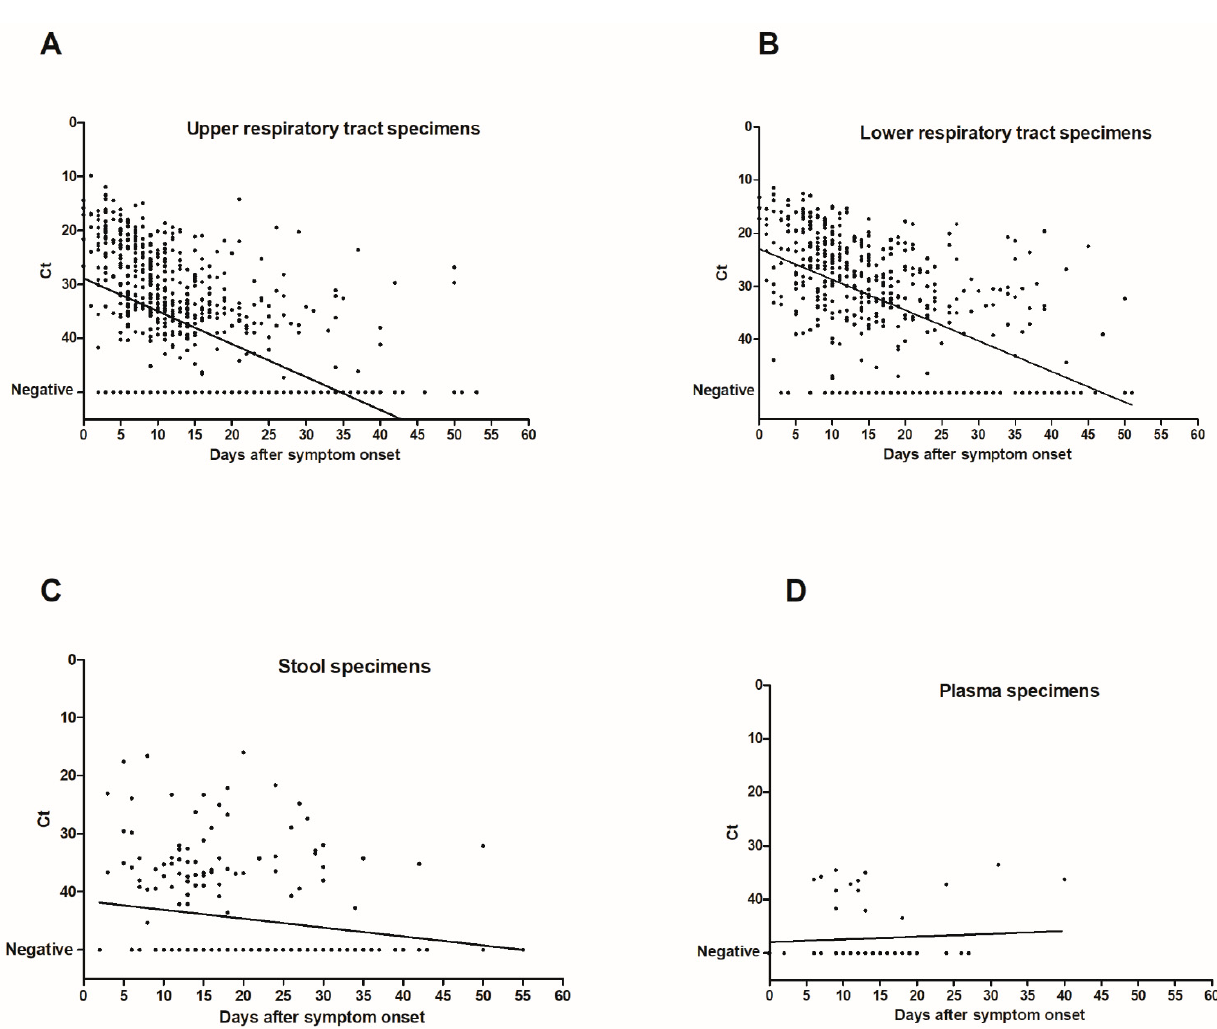
detectable SARS-CoV-2 RNA were set to 50. The linear regression lines are shown in the